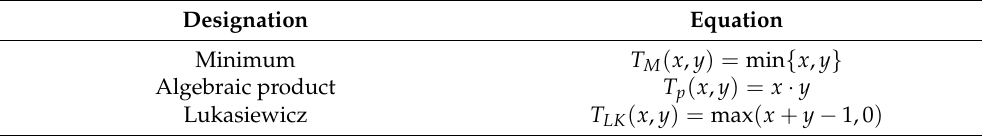
Table 3. Basic t-norms.